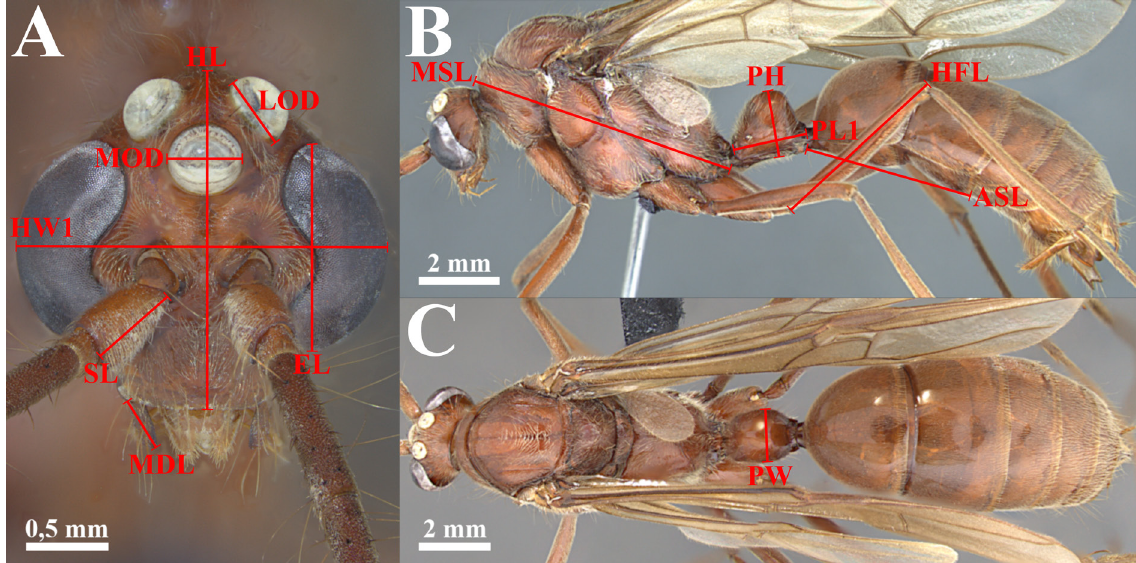
Fig. 2. Measurements of Dinoponera quadriceps Kempf, 1971, ♂ (DZUP 549804). A . Full-face view. B . Full body in lateral view. C . Full body in dorsal